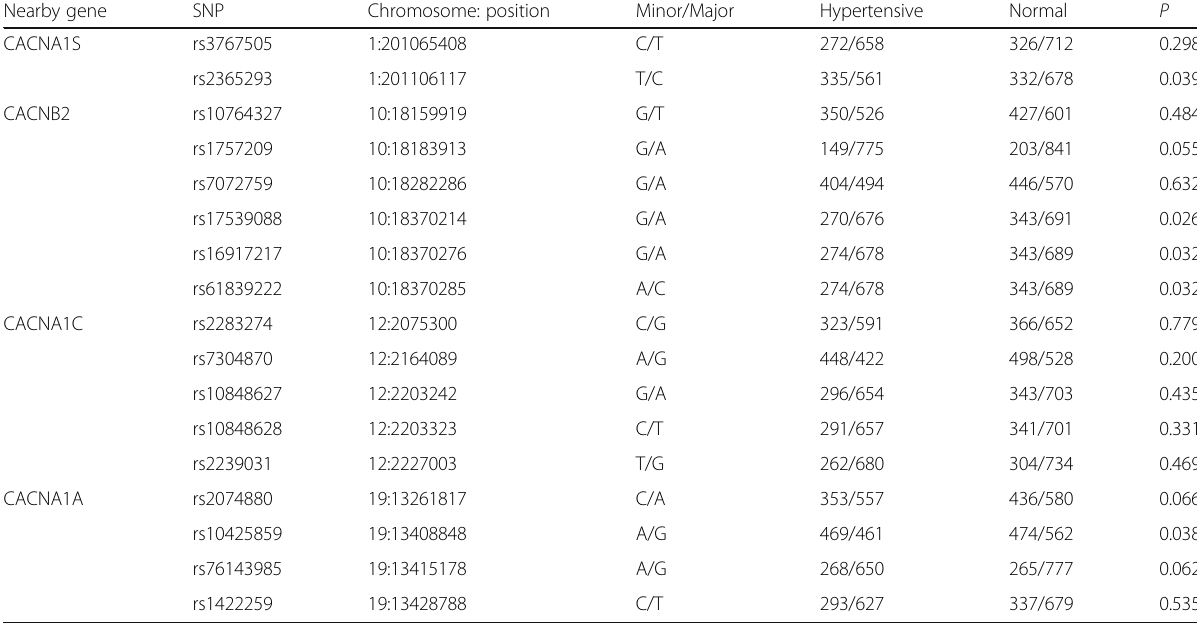
Table 2 Comparison of the 17 SNP frequencies between hypertensive and normal populations Nearby gene SNP Chromosome: position Minor/Major